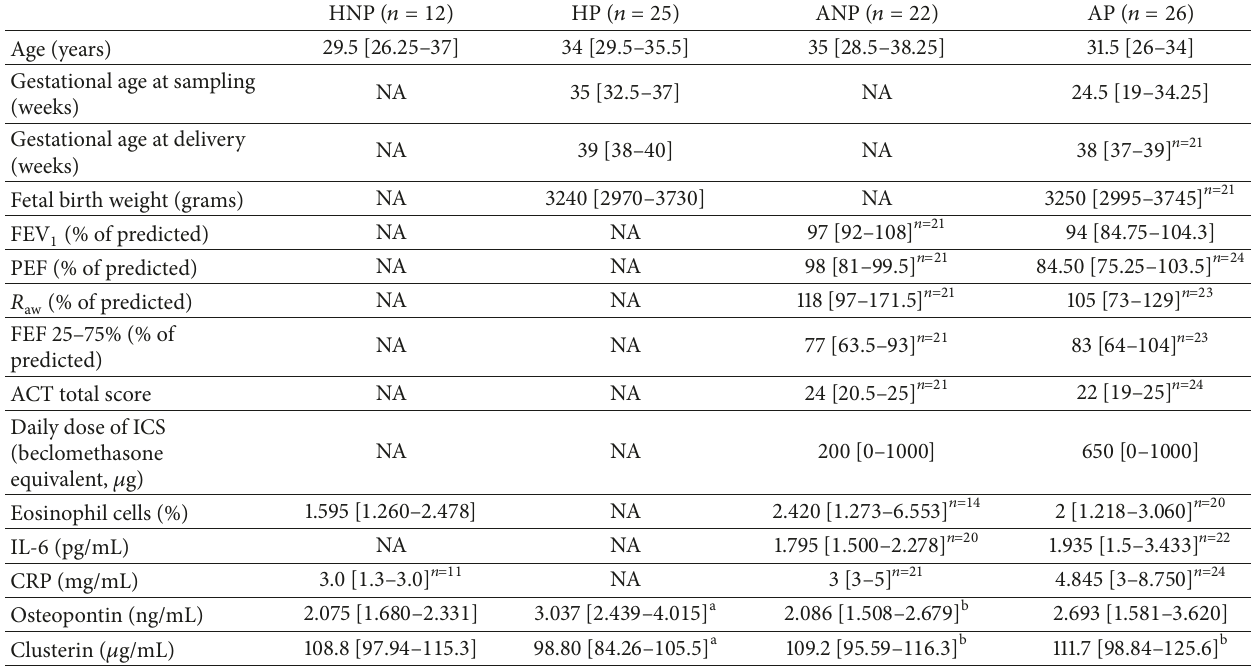
Table 1: Clinical data and inflammatory parameters of the four study groups (median [interquartile